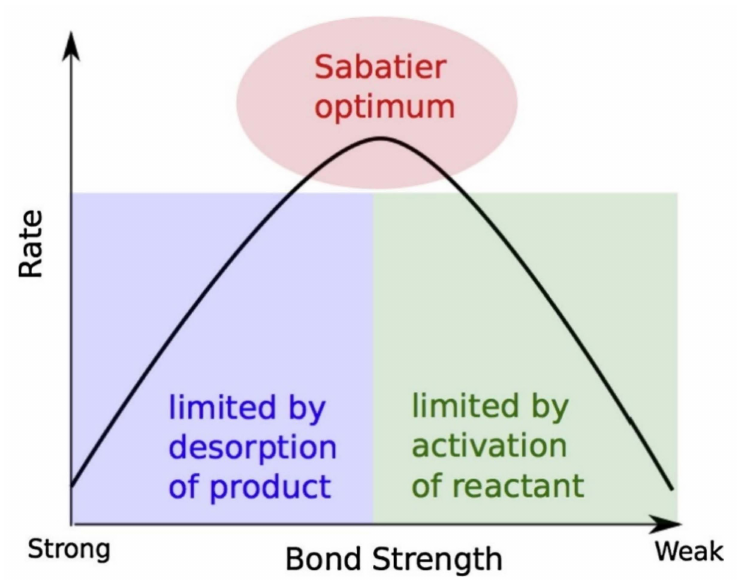
Figure 5. Schematic representation of the qualitative Sabatier principle [45]. (Reprinted with permis- sion from